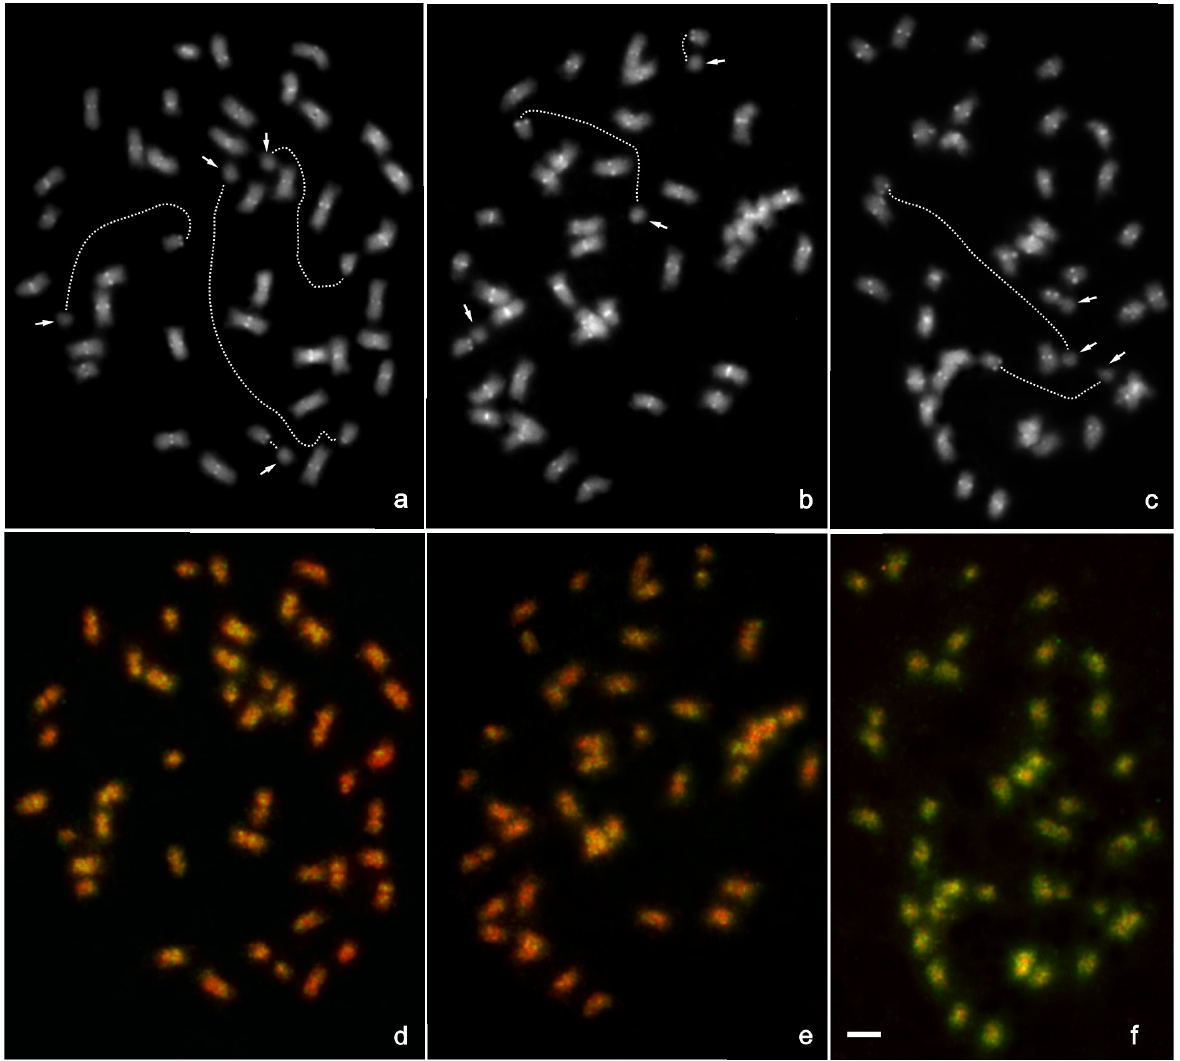
Figure 5. Representative somatic metaphases of tetraploid A. glabrata after double GISH. DAPI staining (gray) was used to highlight the heterochromatic bands and to stain euchromatin in Figs. a, b, and c after double GISH using gDNA probes of d: A. duranensis (green) and A. rigonii (red), e: A. duranensis (green) and A. paraguariensis subsp. capibarensis (red), f: A. paraguariensis subsp. capibarensis (green) and A. rigonii (red). The white arrows point to the satellites, which are attached with dotted lines to the proximal regions of their respective chromosomal arms. Scale bar = 3